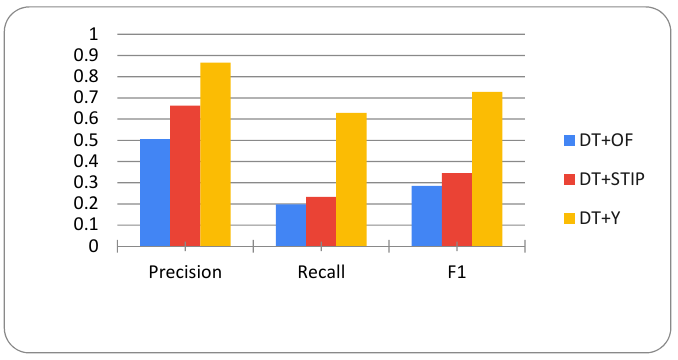
Figure 13. Evaluation results for DT + OF, DT + STIP, and DT + Y activity measures.